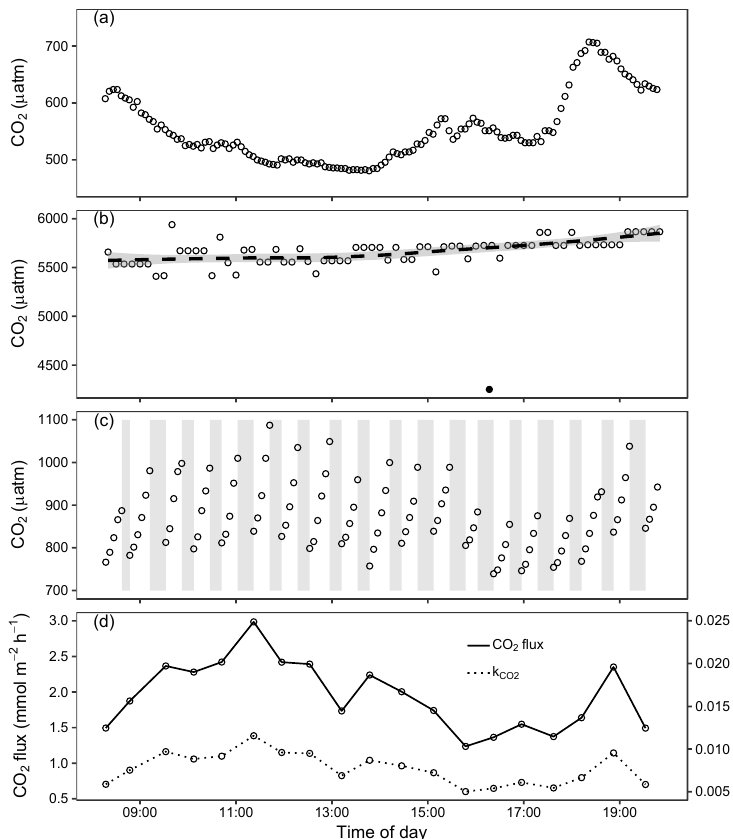
Figure 4. Data from field deployment (14 October) showing (a) atmospheric CO 2 partial pressure (µatm) measured 17cm above the water surface, (b) waterside CO 2 partial pressure (µatm) estimated from pH, water temperature and alkalinity (open points) fitted with a LOESS smoother and inferred from a floating chamber left to equilibrate with surface water (solid point), (c) headspace CO 2 partial pressure (µatm) in the automated floating chamber where the grey boxes show periods of ventilation between gas flux measurements, and (d) the calculated CO 2 gas flux (mmolm − 2 h − 1 ) and gas exchange velocity ( k ,mh − 1 ). The small abrupt changes in estimated waterside CO 2 partial pressure (b) are not real, but are caused by minute pH changes of 0.01 unit (i.e. the resolution of pH